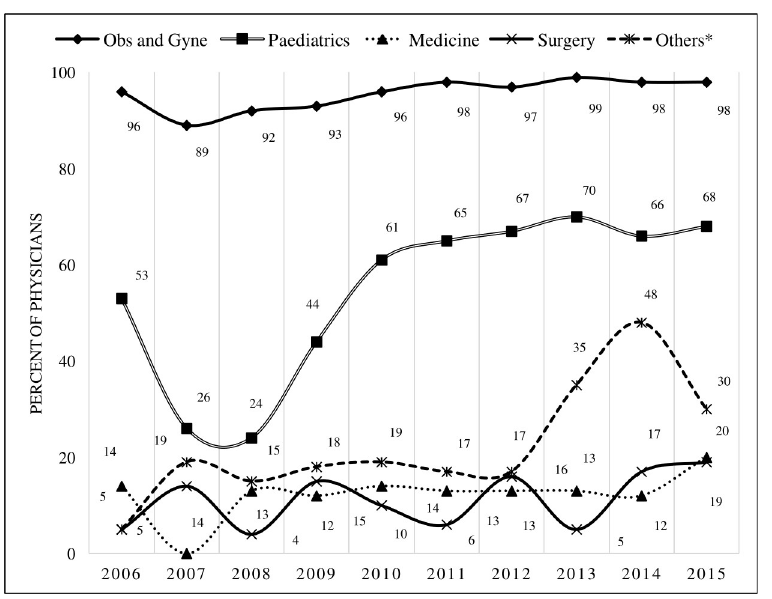
Fig 4. Distribution of female physicians according to specialization